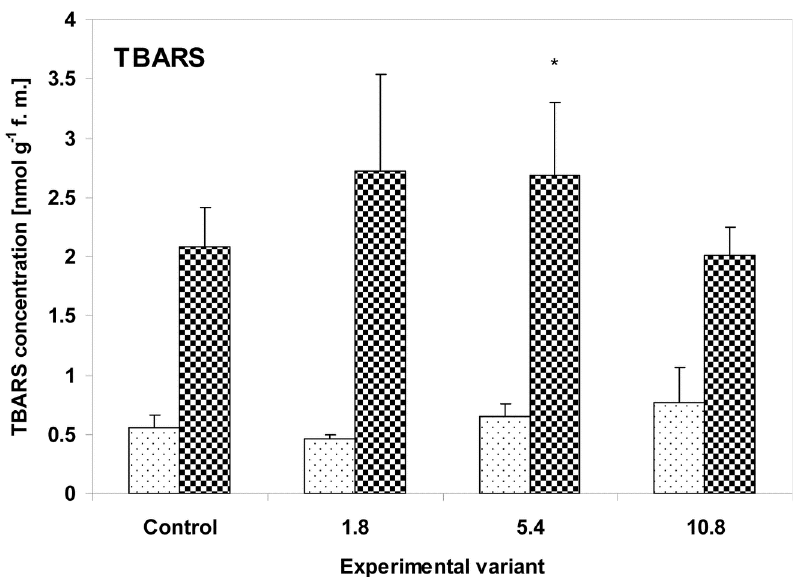
Fig 2. TBARS concentration in the leaves of zucchini (square without filling) and cucumber (square with dots) grown on the control and sewage sludge amended soil. Concentrations are expressed in nmol g -1 f.m. Bars represent S.D. of means ( n = 5 – 8). Symbols ( * ), ( ** ), and ( *** ) indicate values that differ significantly from controls at P < 0.05, P < 0.01, and P < 0.001, respectively. Activities are expressed in nkat mg -1